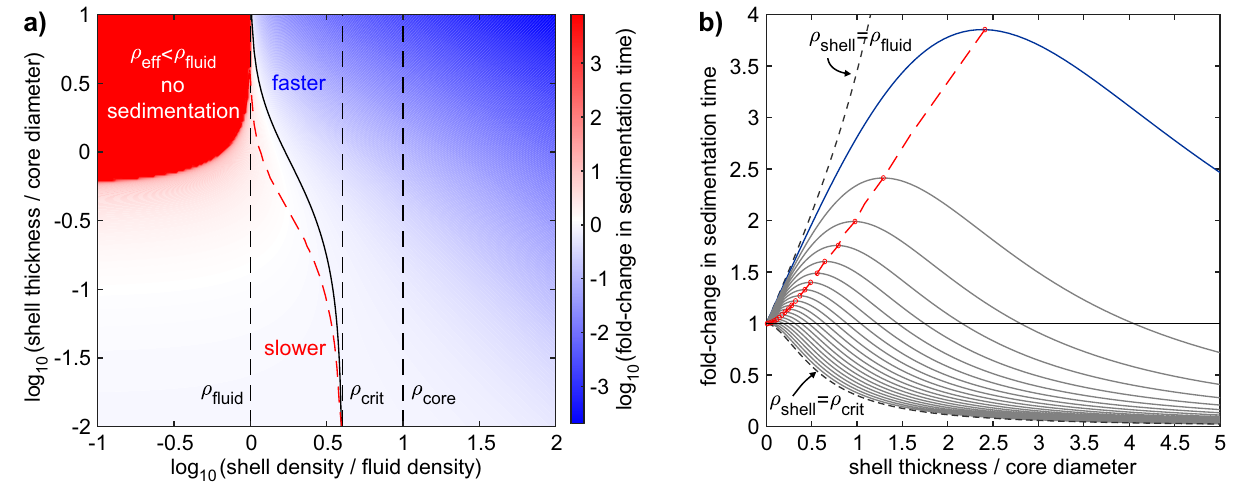
Figure 2. NP sedimentation time as a function of shell density and thickness. ( a ) Shown colour-coded is the fold-change in sedimentation time on a logarithmic scale (white to blue: faster, white to red: slower) relative to the sedimentation time of a bare NP without the shell. The sedimentation time is plotted double-logarithmically versus shell density and shell thickness. It was calculated using Eq. (1) by inserting the total (core plus shell) NP diameter, as well as the effective NP density ρ eff according to Eq. (2) (see “Methods” section). This plot uses normalised parameters in units ρ fl = 1 (left vertical dashed line), d c = 1 , t ( d s = 0 ) = 1 , and it assumes ρ c = 10 (right vertical dashed line). The qualitative behaviour shown remains valid for all ρ c > ρ fl . Indicated are also the critical shell density ρ crit (middle vertical dashed line), as well as the maximum sedimentation time (red dashed line) for shell densities in the range ρ fl < ρ s < ρ crit . ( b ) For different values of shell densities in the range ρ fl < ρ s < ρ crit , the fold-change in sedimentation time increases and decreases as a function of the shell thickness. The red circles and dashed line represent the maximum sedimentation time for a certain shell density. Note that in theory two different shell thickness can give rise to the same fold change > 1, which is not a concern in the practical situation (blue curve) where the shell thickness never exceeds 2.5 times the core diameter. Image obtained with